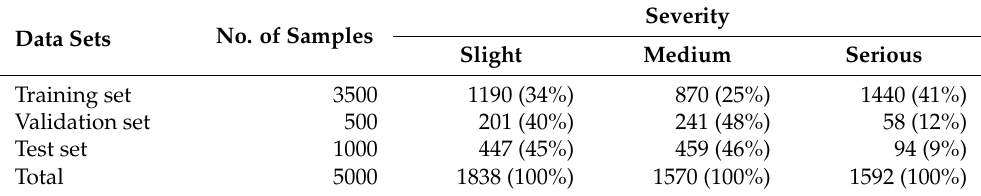
Table 4. Experimental data